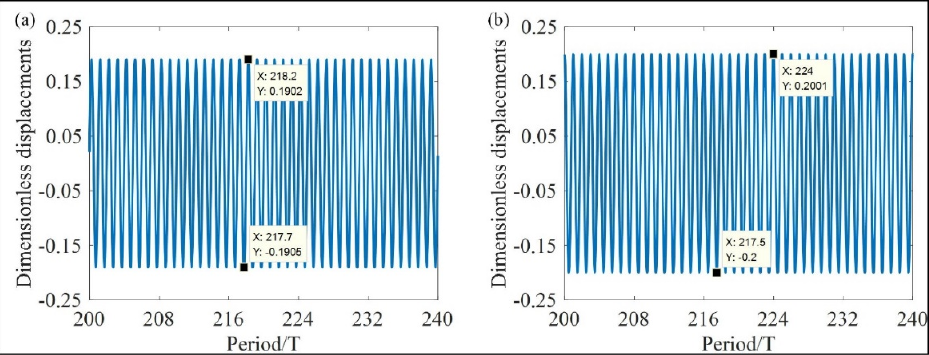
Figure 3. ( a ) The dimensionless relative displacement of the gear 1 and gear2, ( b ) the dimensionless relative displacement of the gear 1 and gear 3.